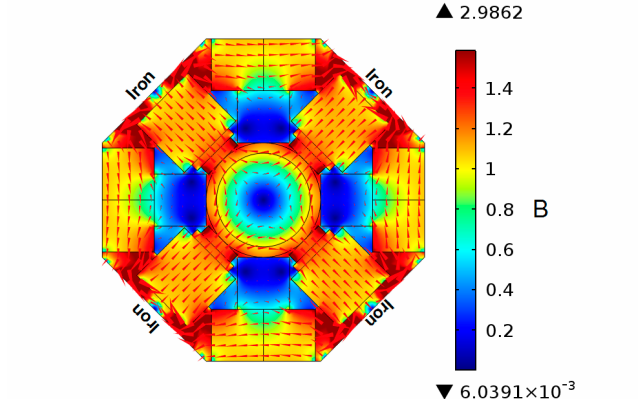
Figure 2. The layout of the PMQs system prototype based on hybrid Halbach